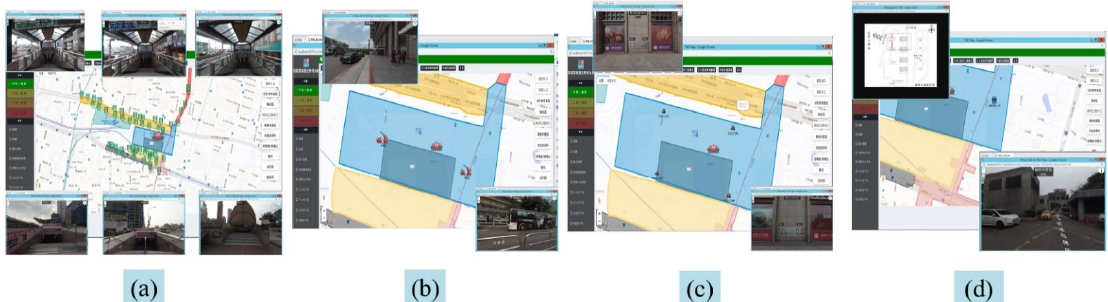
Figure 12. Disaster management: One-click integration to automatically trigger response and report to the fire department and co-construction units. (Source: Research Data). (a) One-click trigger; (b) LINE report; (c) Marquee information; (d) Disaster location; (e) BIM escape; (f) Level-3 signal trigger; (g) CCTV; (h) Nearest exit; (i) Nearest fire escape.